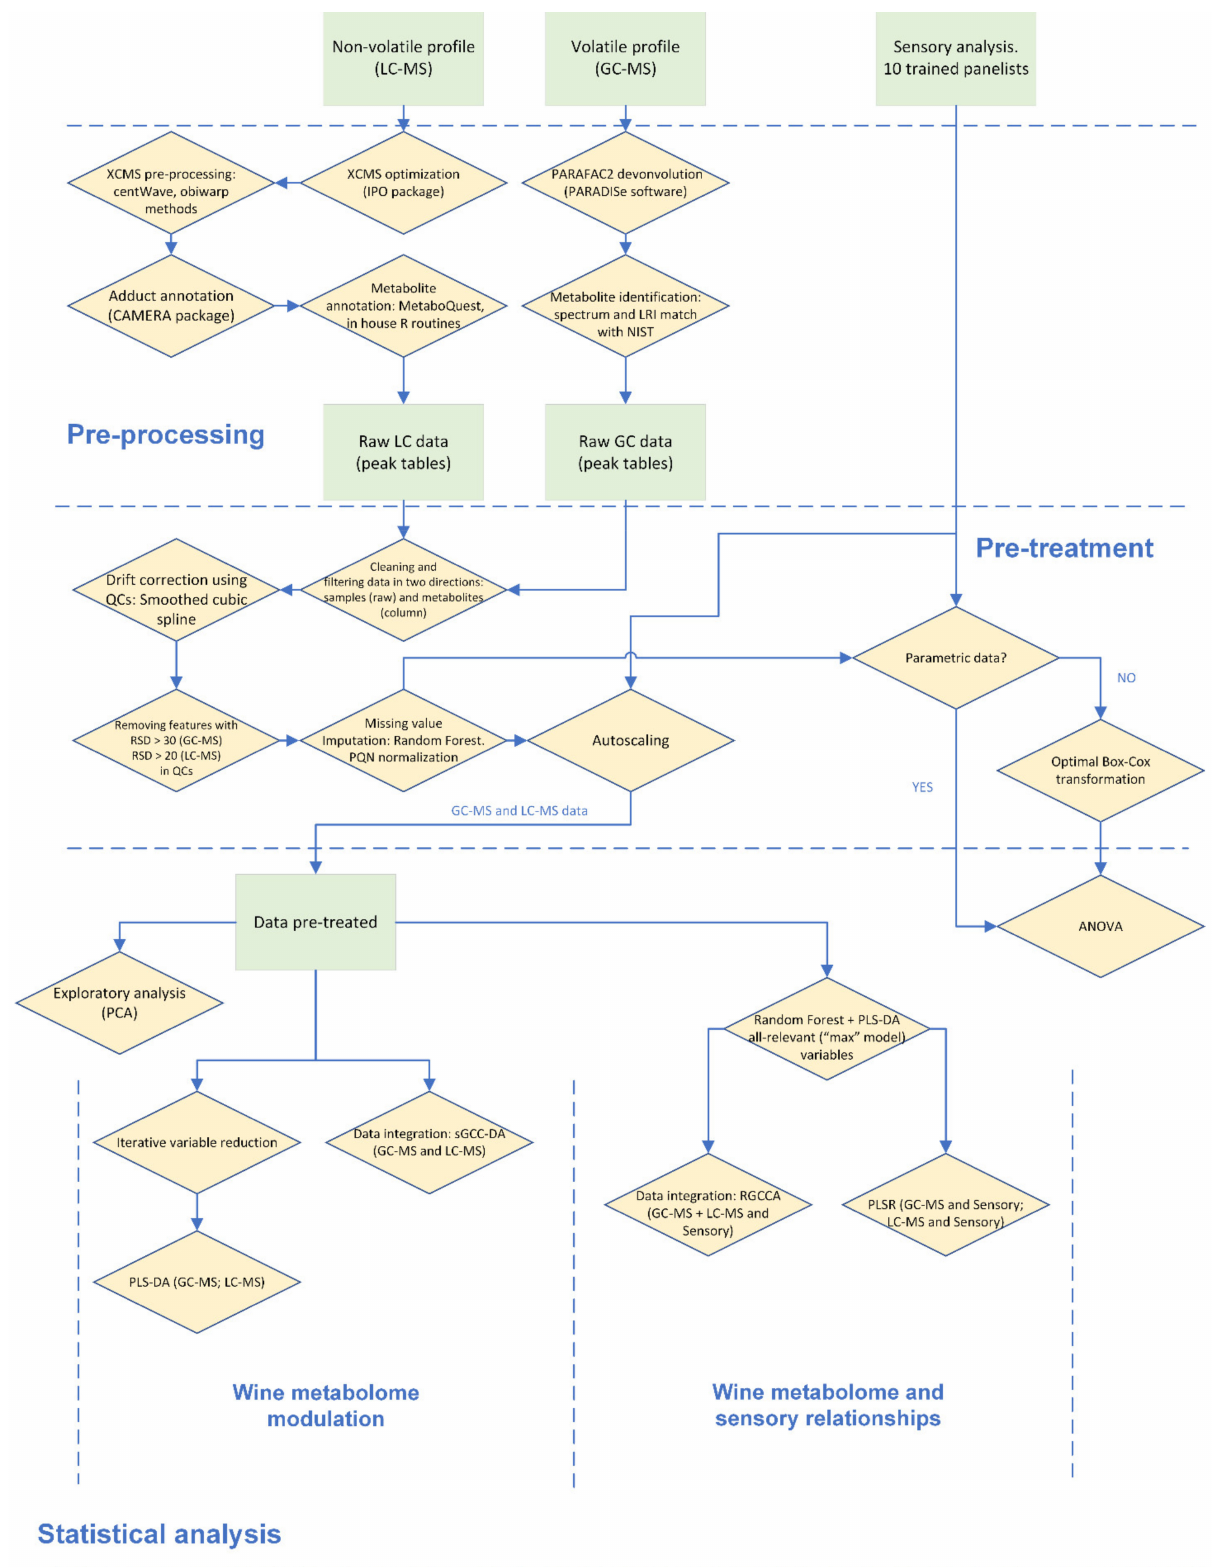
Figure 1. Flowchart illustrating the step-by-step processes followed to convert raw data into processed data to extract biological